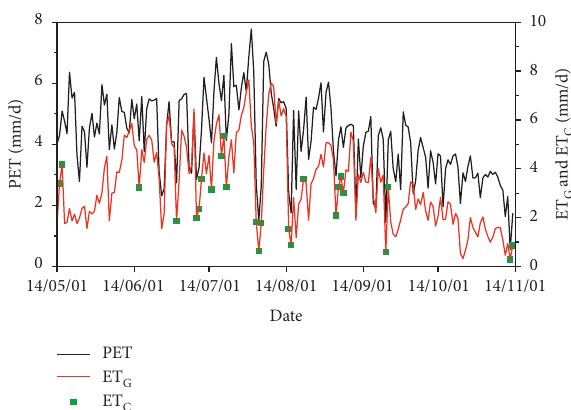
Figure 8: Estimated groundwater evapotranspiration (ET interpolated evapotranspiration rate (ET C ) based jointly on the white and Mazur’s methods and potential evapotranspiration (PET) at the observation site G6.